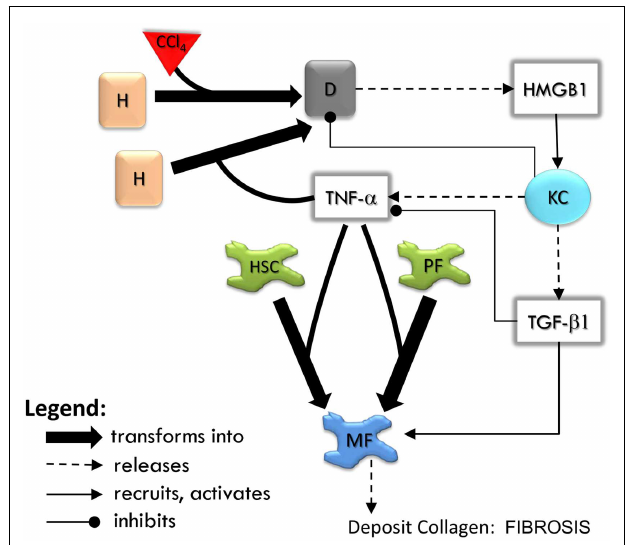
FIGURE 2 |An overview of agent interactions in the model . H, hepatocyte; D, dead hepatocyte; KC, Kupffer cell; HSC, hepatic stellate cell; PF, portal fibroblast; MF, myofibroblast. Diffusible factorsTNF- α , tumor necrosis factor alpha;TGF- β 1, transforming growth factor beta 1; HMGB1, high mobility group box protein 1. Detailed rules are available in Supplementary